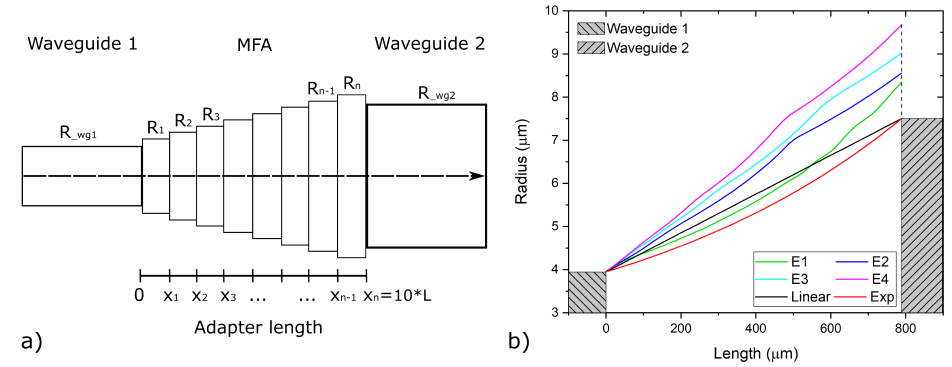
Figure 4. ( a ) Scheme of iterative method of MFA design. ( b ) Mode field adapter profiles designed based on the different linearly polarized (LP) fiber modes: E1 for the LP 01 , E2 for the LP 11 , E3 for the LP 21 and E4 for the LP 02 . Additionally, linear and exponential profiles joining the two waveguide cores are